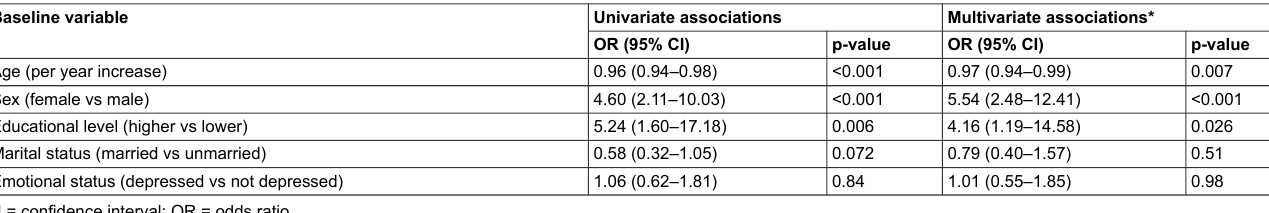
Emotional status (depressed vs not